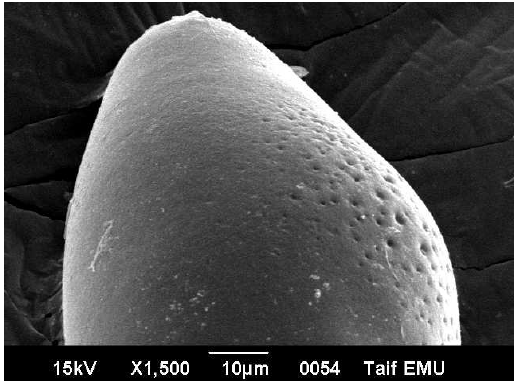
Figure 5. Fasciola egg treated in vitro with the drug with nano silver particles. Notice the perforations on the egg surface due to the effect of drug carried on nano silver